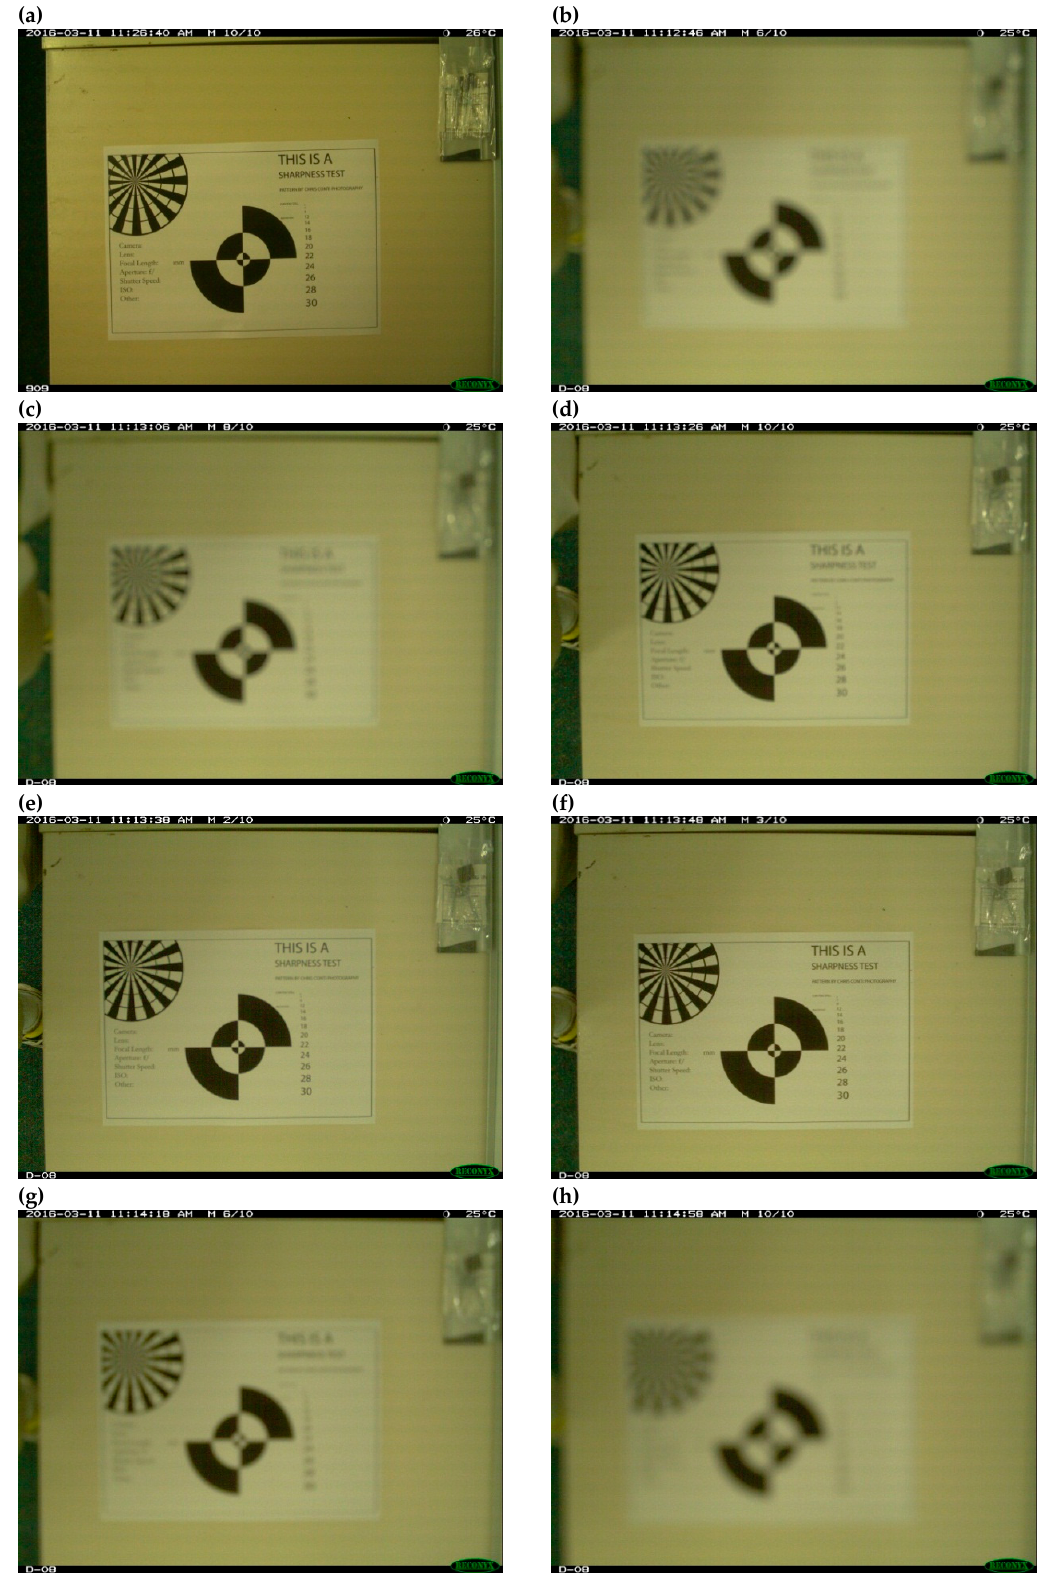
Figure 9. Image sharpness test results from ( a ) a factory modified Reconyx PC900, and ( b )–( h ) a practitioner modified Reconyx HC600 camera-trap. Images ( b )–( h ) show the change in image sharpness as the camera lens is wound through its focal range.